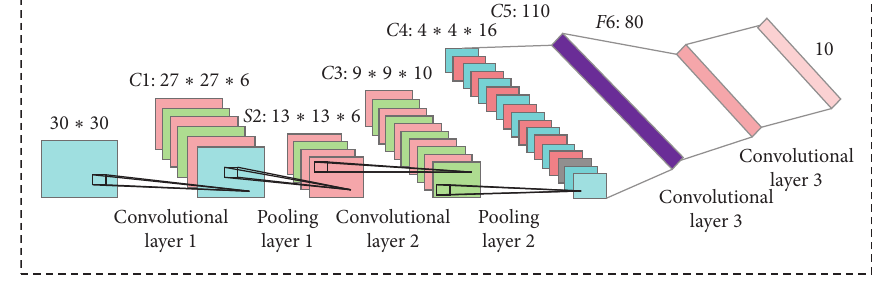
Figure 5: SqueezeNet SSD object detection model